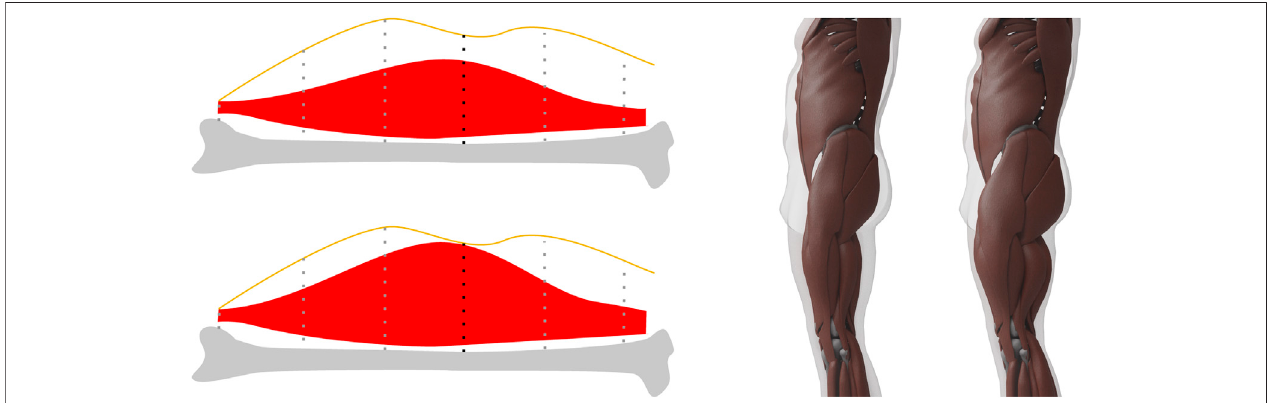
FIGURE 7 | Left. When computing the maximum muscle surface, we move muscle vertices toward the skin by an amount proportional to their muscle potential , which for each vertex is the length of the dotted line intersected with the muscle. The vertex with the black dotted line de fi nes the maximum allowed stretch in this example. Right: An example of our minimum and maximum muscle layers for the same target. These two surfaces de fi ne the lower and upper limit for the muscle mass and vice versa for the fat mass.